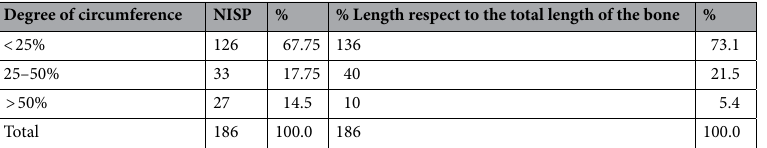
Table 6. Degree of total circumference and fragment length vs complete bone length. Only green fractured bones are